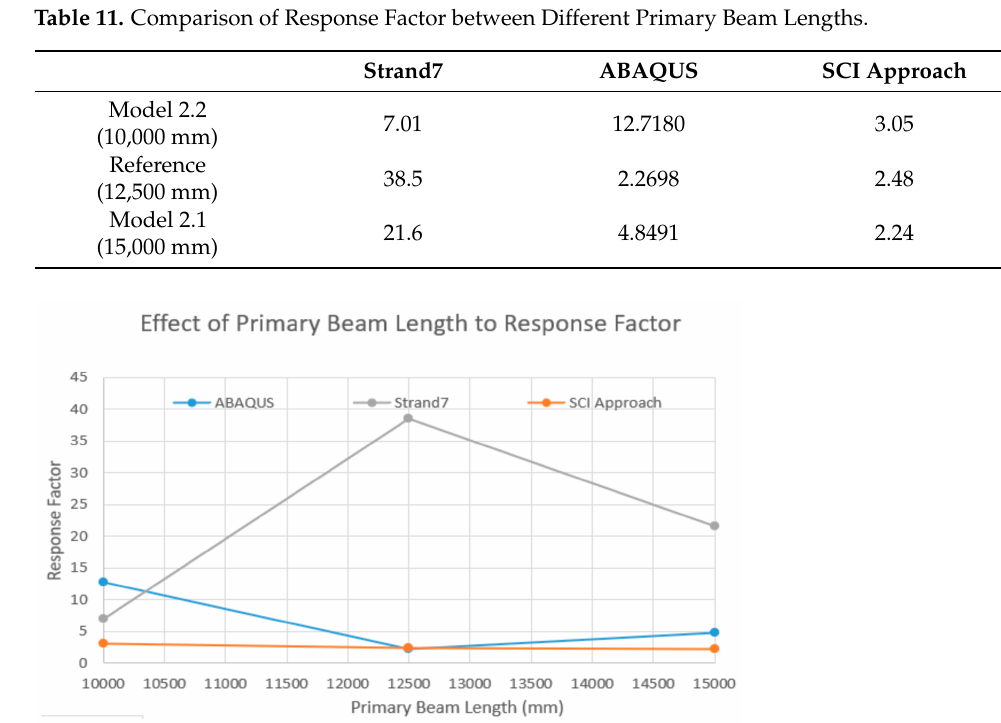
Figure 15. Comparison of Response Factor between Different Primary Beam